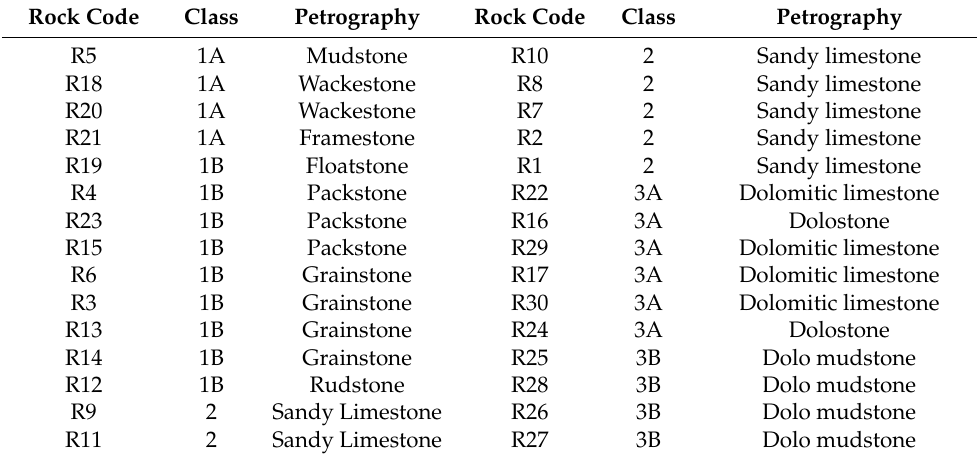
Table 6. Rock classes based on petrographic study. Rock